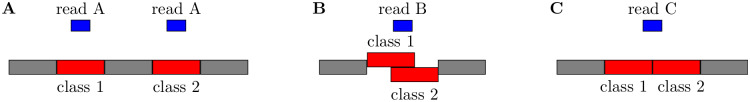
Ambiguous cases of sRNA class quantification.In each figure, the read is in blue, intergenic regions are grey, and known annotated sRNAs are red. (A) The read A maps at two different locations, and each mapping overlaps with a different sRNA annotation class. (B) Two sRNA annotation classes overlap in the annotation file. (C) The read overlaps two different sRNAs annotation classes that do not overlap each other.